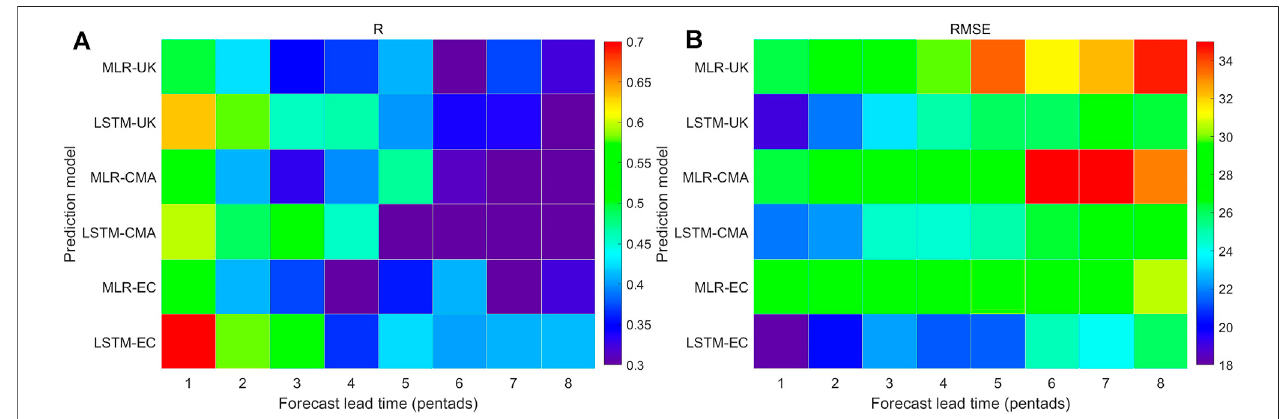
FIGURE8| Correlationcoef fi cients(the95%con fi dencelevelis0.18) (A) andRMSE (B) betweenPM 2.5 concentrationpredictionswithdifferentperiod validity(one to eight pentads) (x-axis) of MLR and LSTM predictions based on CMA, U.K., and ECMWF models and the actual condition.